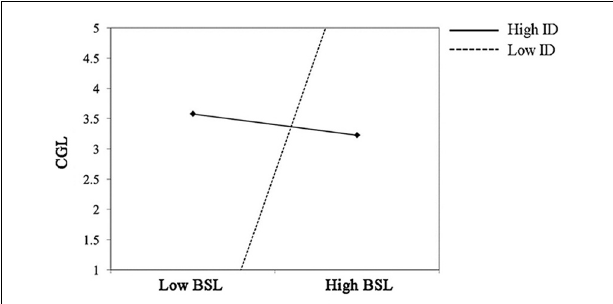
FIGURE 2 | Interaction between BSL and ID on CGL.